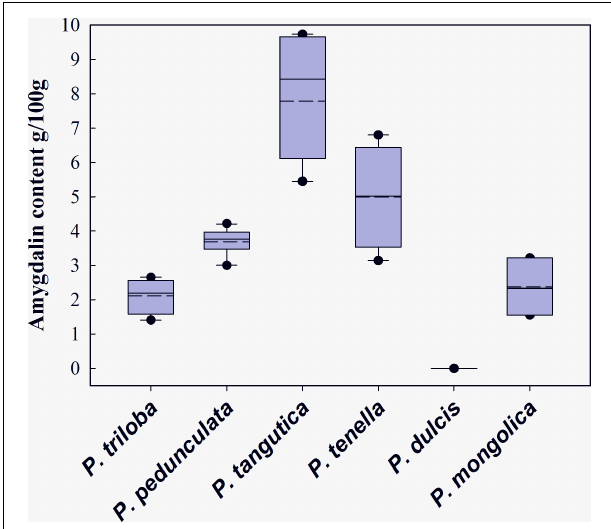
FIGURE 2 | Range of amygdalin contents in six almond species in China. Medium dashed lines show each mean value, and solid lines show each